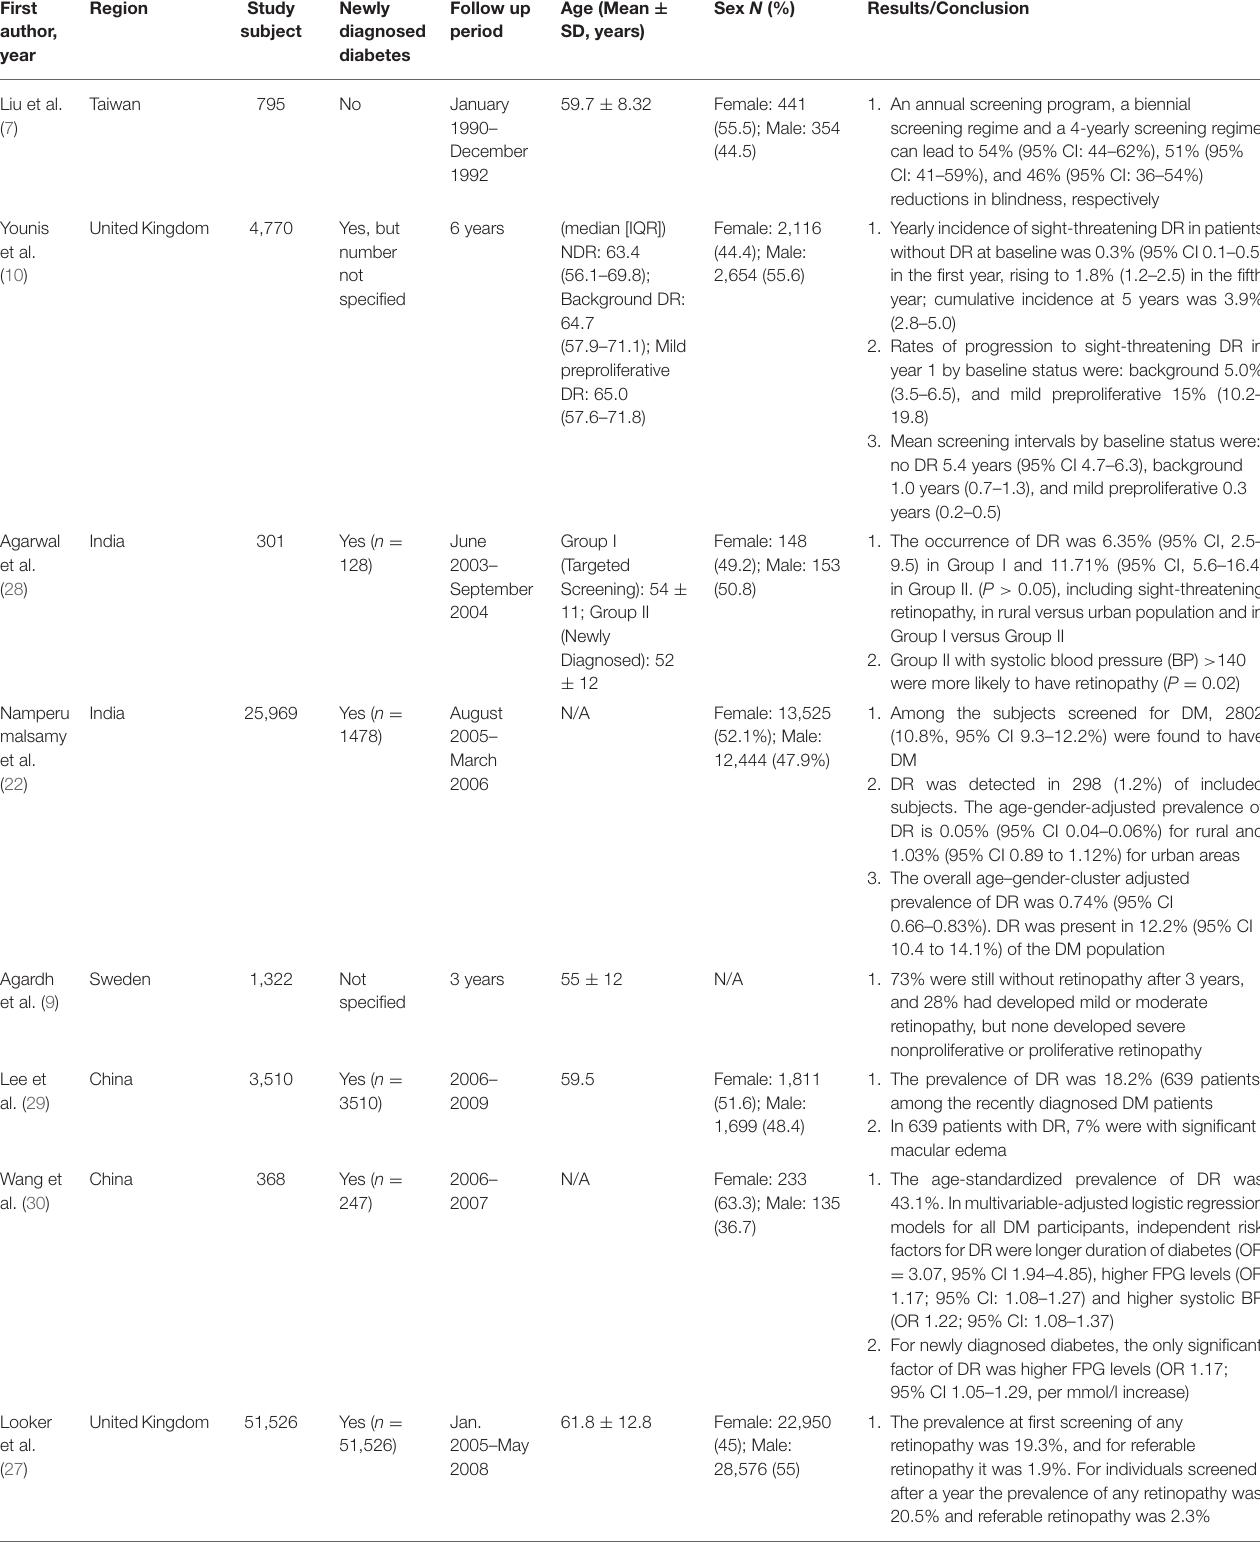
TABLE 5 | Characteristics of the relevant